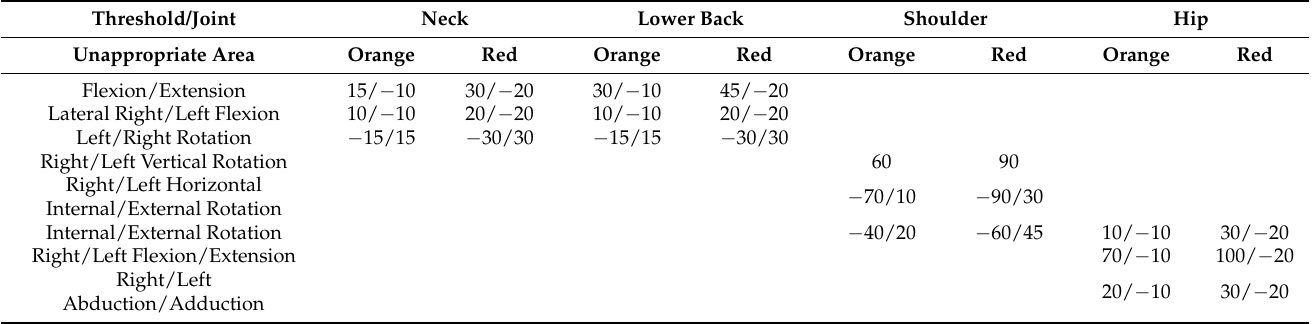
Table 2. Angle thresholds [ ◦ ] set for monitoring the motion of the measured joints: Neck, Lower Back, Right/Left Shoulder, Right/Left Hip. Thresholds were set according to the author’s [41] recommendation and are part of the collected data evaluation and sorting according to the length of time spent in a given